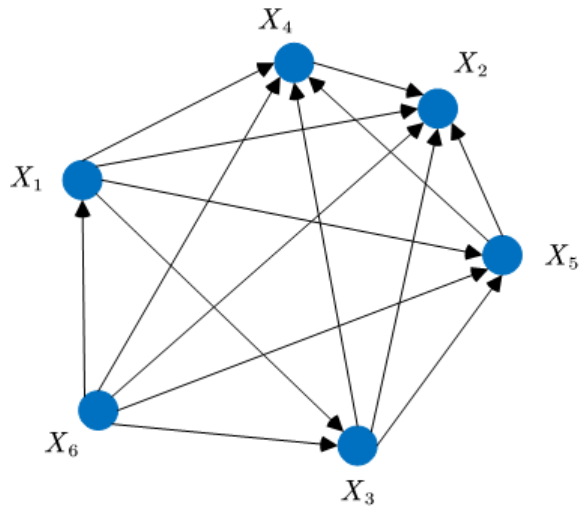
Figure 1. The full attraction